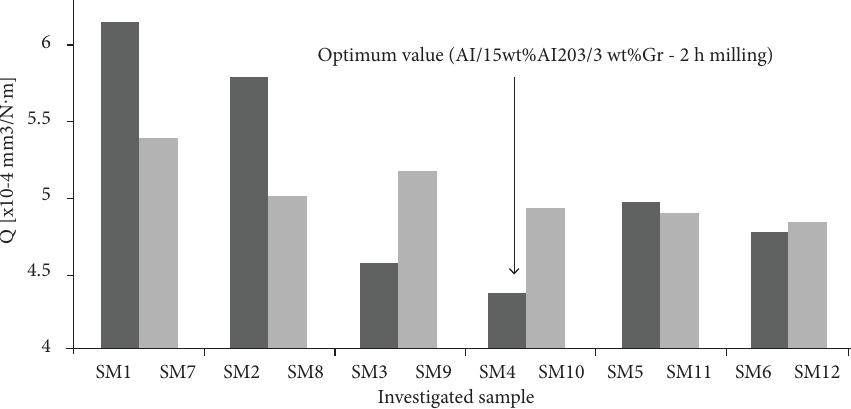
Figure 11: Wear rate of the hybrid composites, reproduced with permission from Ref. [78], copyright 2015,